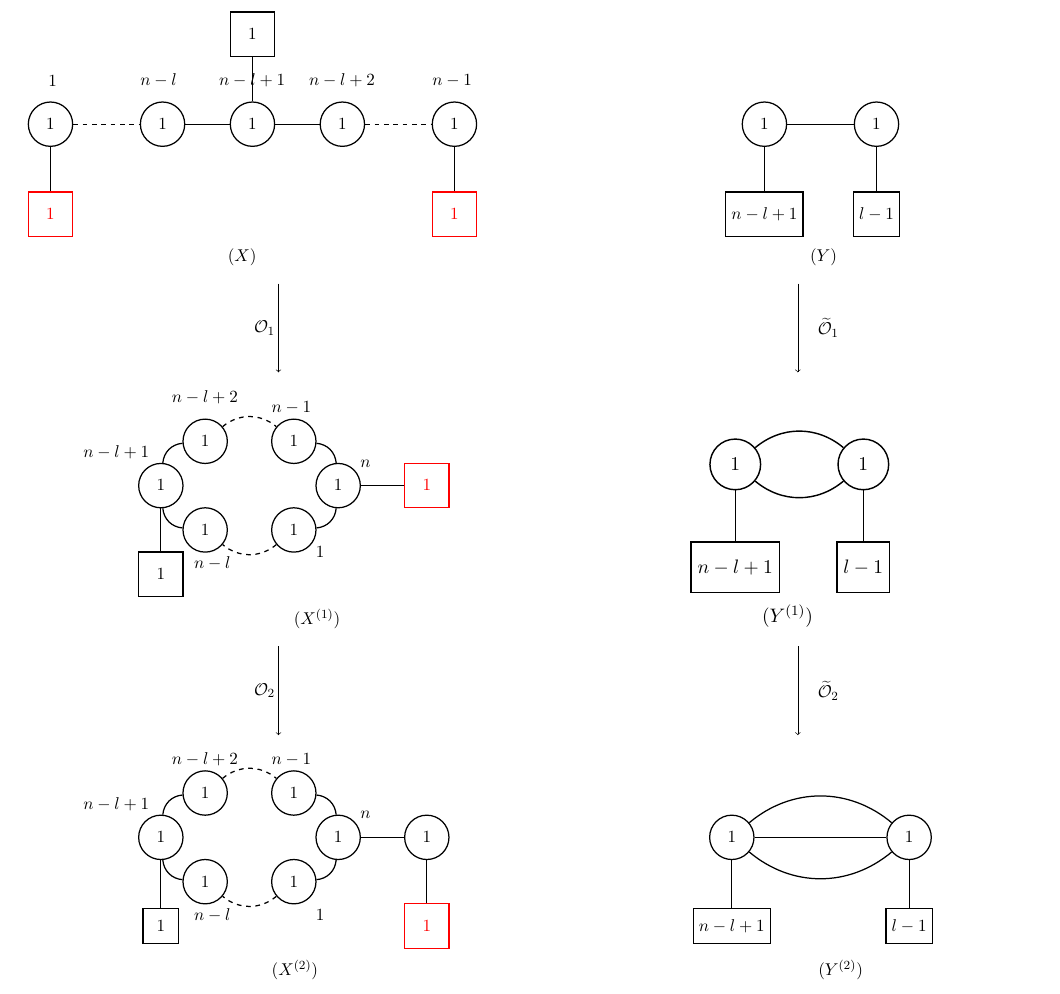
Figure 19 . The quiver ( X 0 ) and its mirror dual ( Y 0 ) in figure 17 (for p = 3 ) is generated by a sequence of elementary S -type operations on different nodes. In each step, the flavor node(s) on which the S -type operation acts is shown in